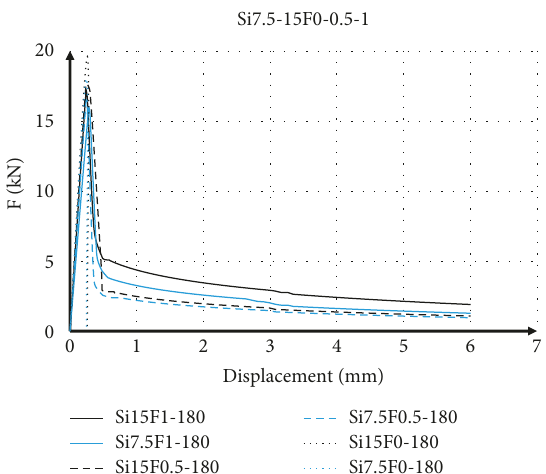
Figure 10: Effect of MPW fiber on flexural behavior of concrete containing silica fume at 180